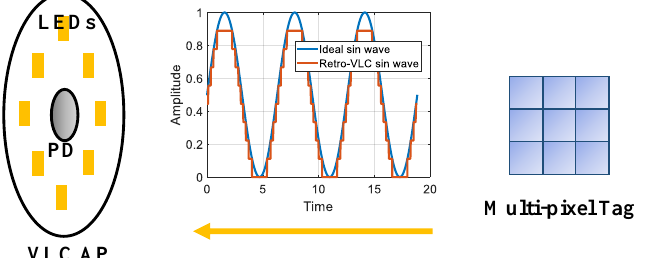
Figure 3. Signal distortion caused by multi-pixel design in Retro-VLC